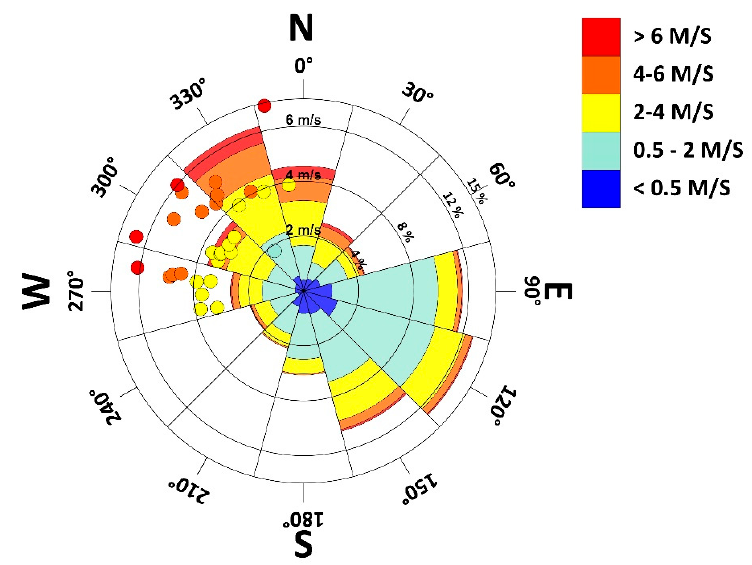
Figure 10. Wind speed frequency (%) with accruing wind directions and velocities in yearly resolution showed by segments and during the validation measurement hours showed by dots (m/s).